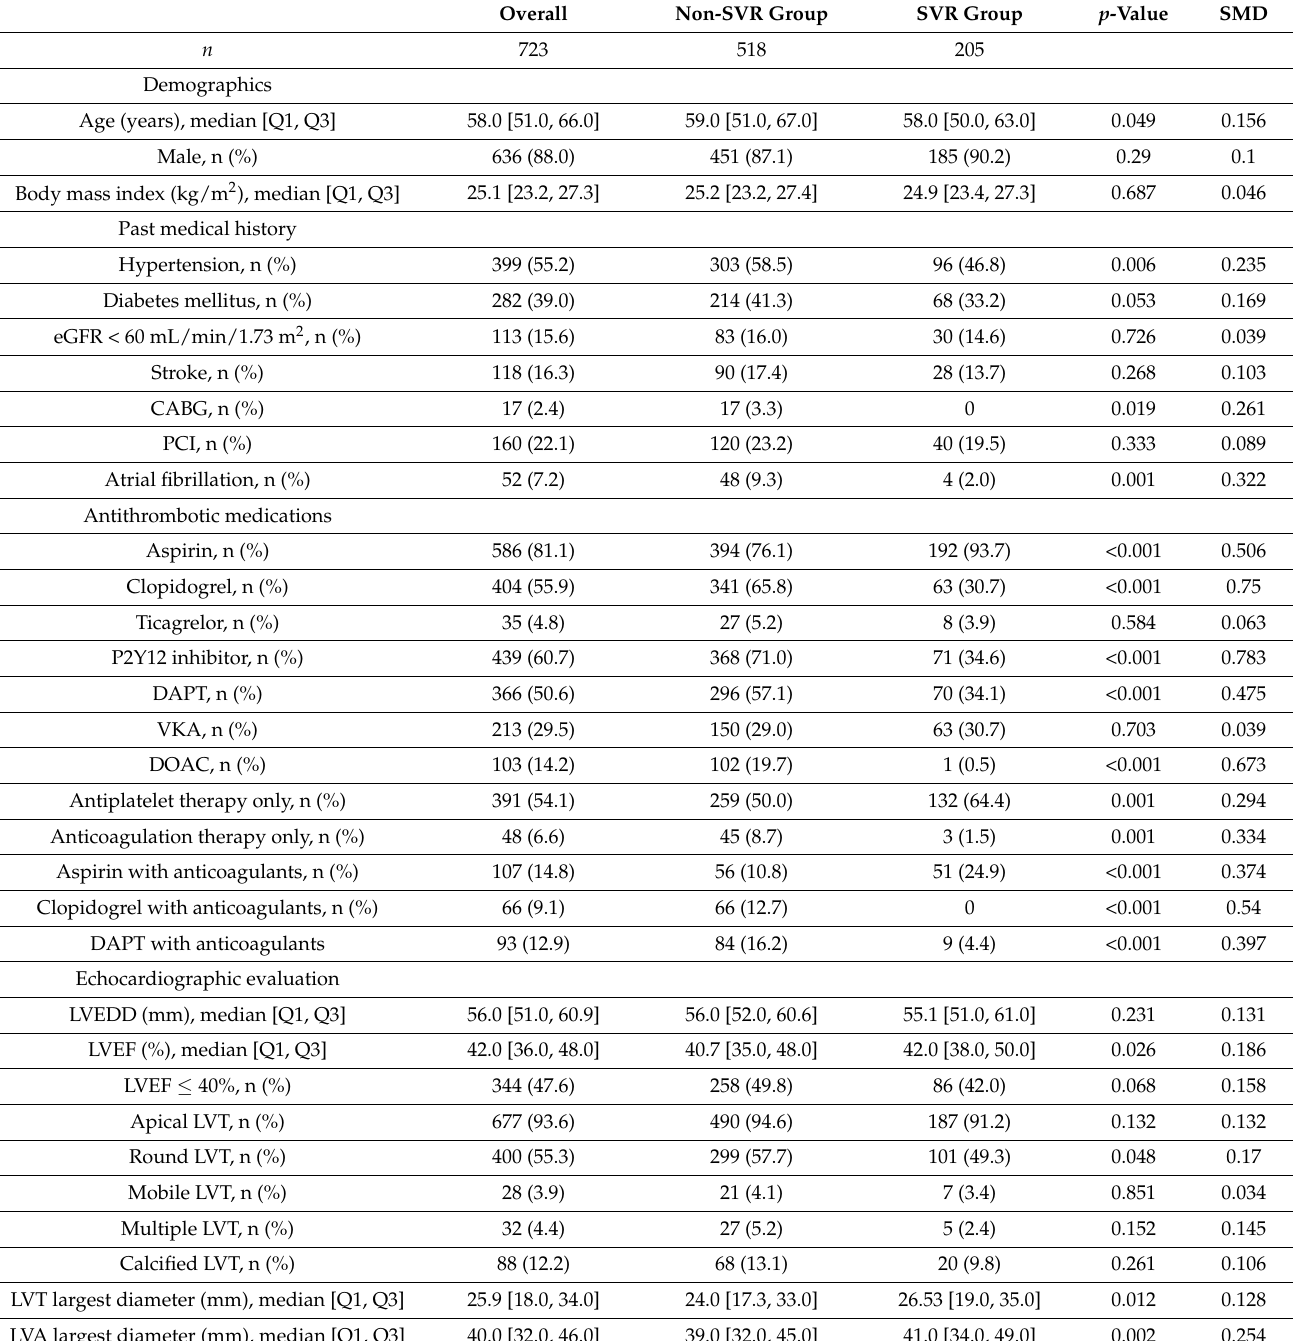
Table 1. Baseline features in the whole population and according to SVR